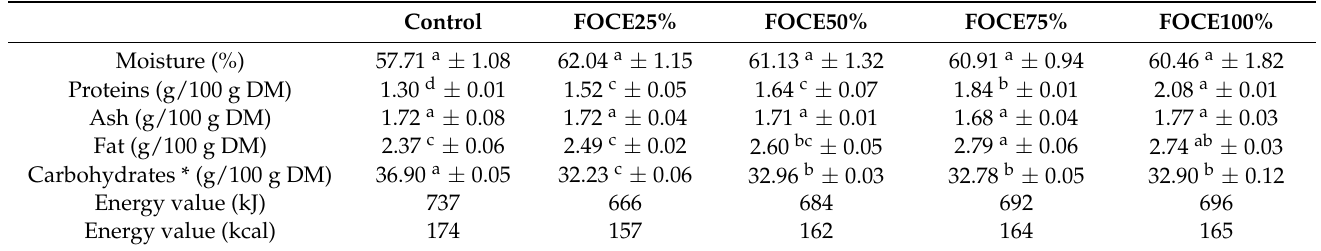
Table 1. The nutritional and energy value of the gluten-free breads with FOCE replacing water.